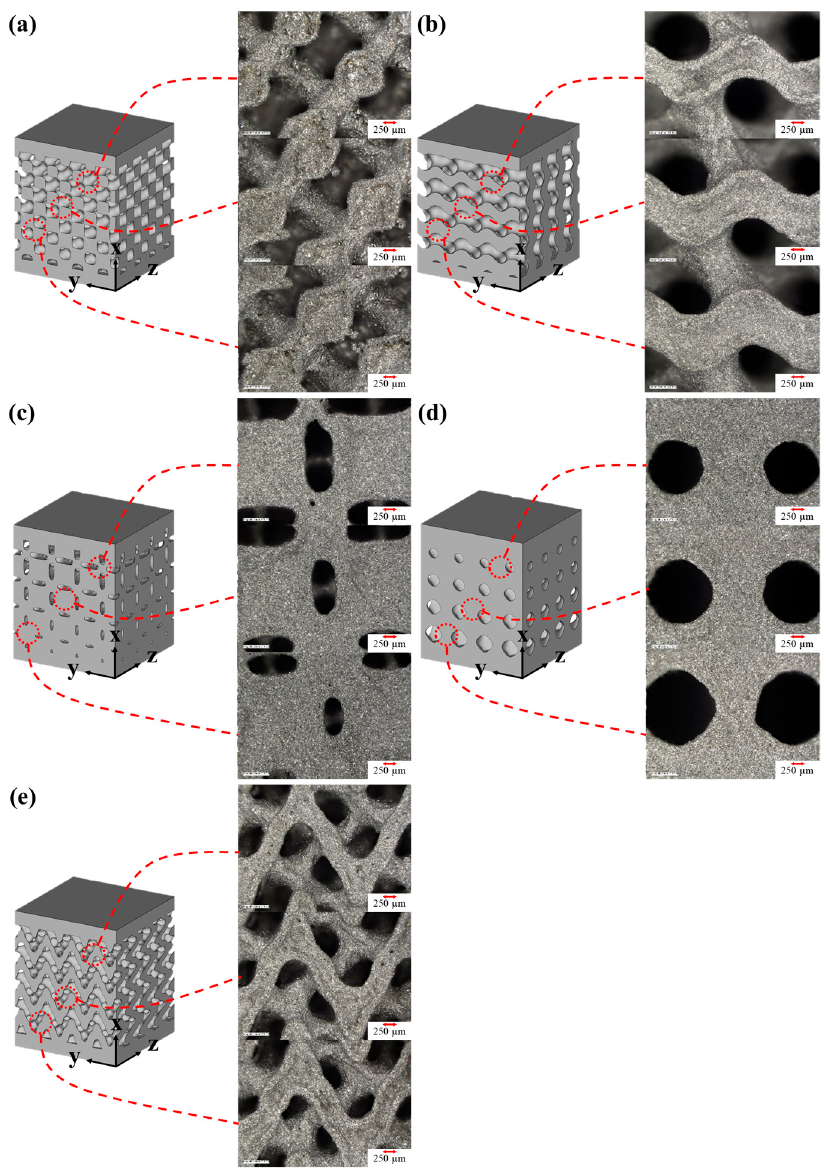
Figure 4. Surface morphologies of LPBF ( a ) Diamond, ( b ) Gyroid, ( c ) Neovius, ( d ) Primitive, and ( e ) Fisher–Koch S type TPMS samples after sandblasting. ( e ) Fisher–Koch S type TPMS samples after